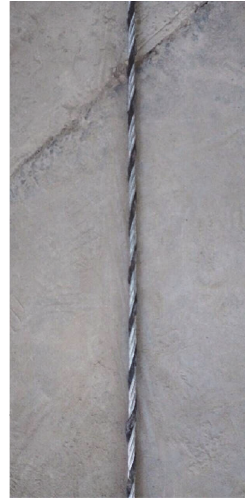
Figure 4: Damaged part of the cable.